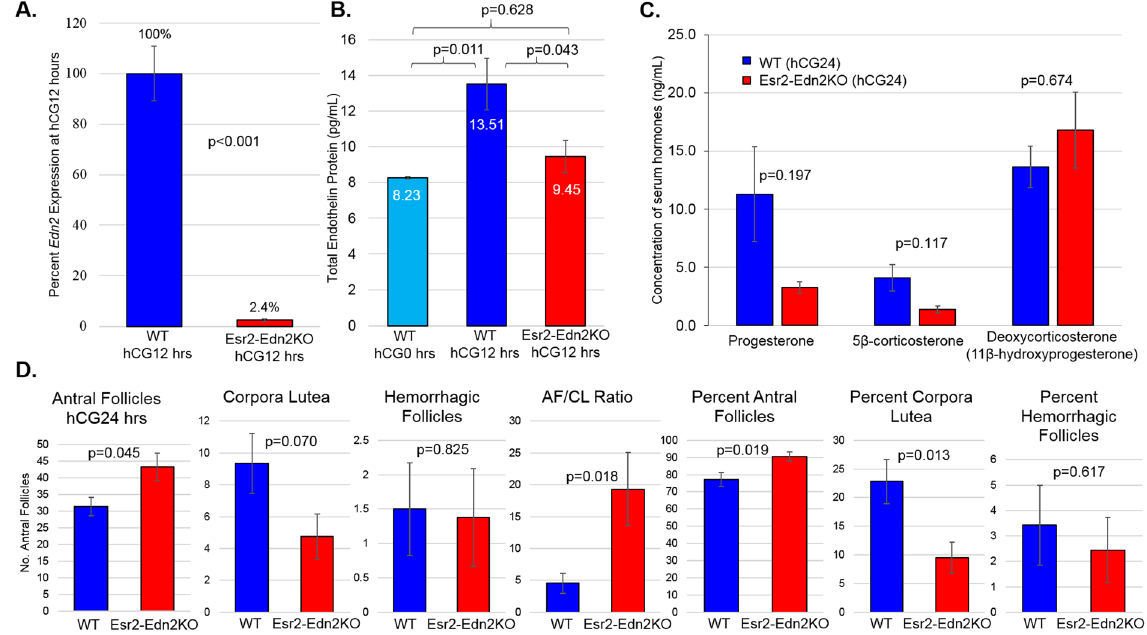
Figure 4. Esr2-Edn2KO mice have more antral follicles and fewer corpora lutea after ovulation. ( A ) Taqman quantitative RT-PCR results comparing Edn2 expression in WT and Esr2-Edn2KO mice at hCG12 hours; 97.6% of Edn2 expression is lost. ( B ) ELISA quantitation of total Endothelin protein per ovary. Endothelin mass is significantly reduced at hCG12 hours in Esr2-Edn2KO mice and is not different at hCG0 hours from WT mice. ( C ) Serum was extracted from PND25 mice at hCG24 hours and serum hormone concentrations (ng/mL) were quantified by LC/MS/MS. P-values represent ANOVA score by hormone. Error bars represent the SEM. ( D ) Ovaries were collected at hCG24 hours from PND25 mice, fixed, and serially sectioned. The absolute number of corpora lutea (CL), antral follicles (AF), and follicles with hemorrhage present were counted. The value is also expressed as a percentage of total ovarian structures. Error bars represent the